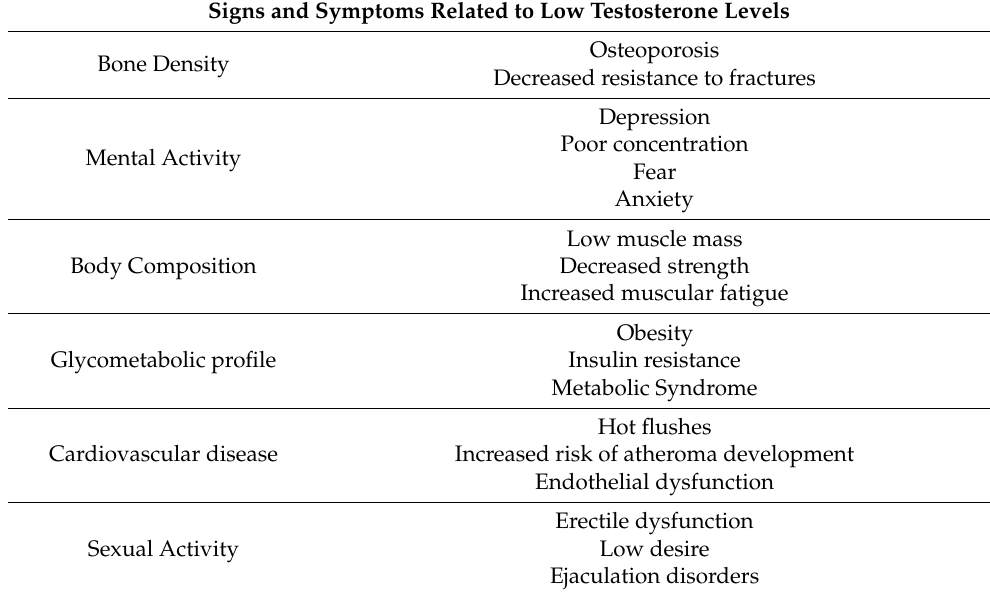
Table 2. Signs and symptoms related to low testosterone